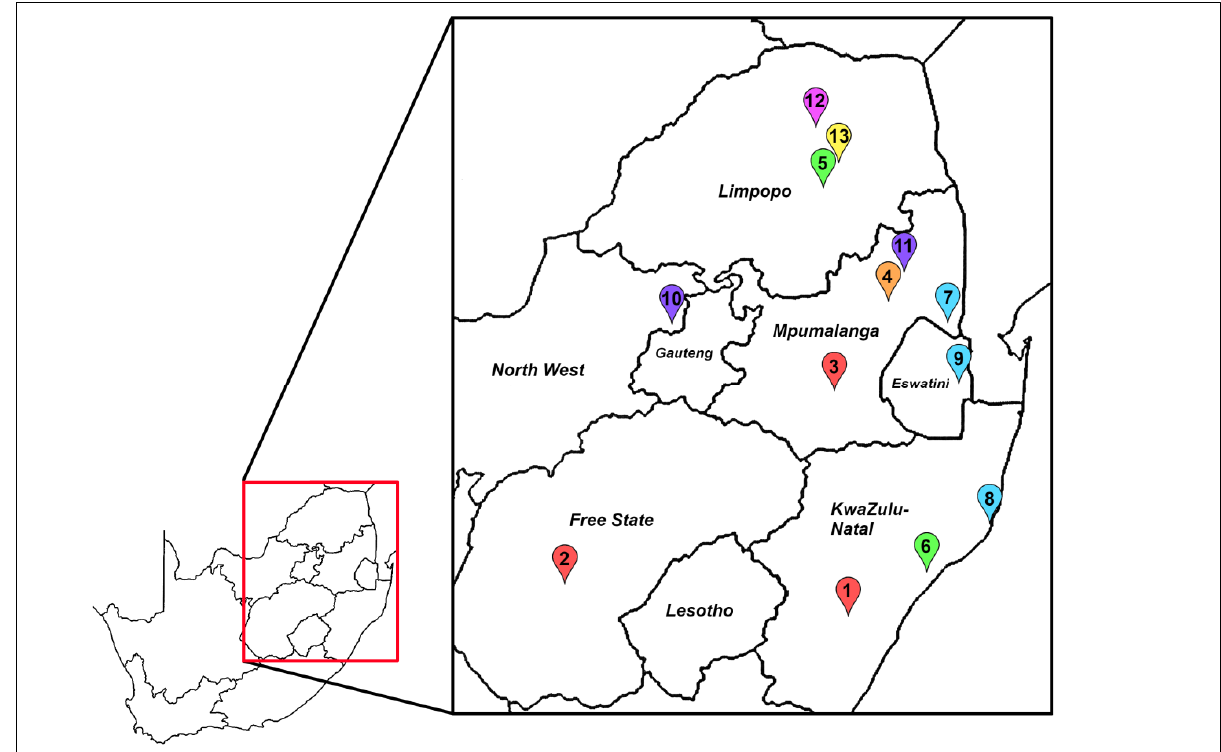
Figure 1: Map of plant viruses identified between 1985 and 2012: Ryegrass mosaic virus in KwaZulu-Natal (1), Free State (2) and Mpumalanga (3); Guar green-sterile virus in KaNgwane (now eastern Mpumalanga near White River) (4); Avocado sunblotch viroid near to Magoebaskloof, Limpopo Province (5) and near Eshowe (KwaZulu-Natal) (6); African cassava mosaic virus and East African mosaic virus in Mpumalanga (7) and in St. Lucia in KwaZulu-Natal (8); South African cassava mosaic virus in Mpumalanga (7) and Swaziland (9); Tobacco leaf enation virus in Brits region (North West Province) (10) and near Hazyview in Mpumalanga (11); genetic variants of Sweet potato mosaic-associated virus and Sweet potato leaf curl Sao Paulo virus near Louis Trichardt, Limpopo Province (12); and Pepino mosaic virus near Mooketsi, Limpopo Province (13).